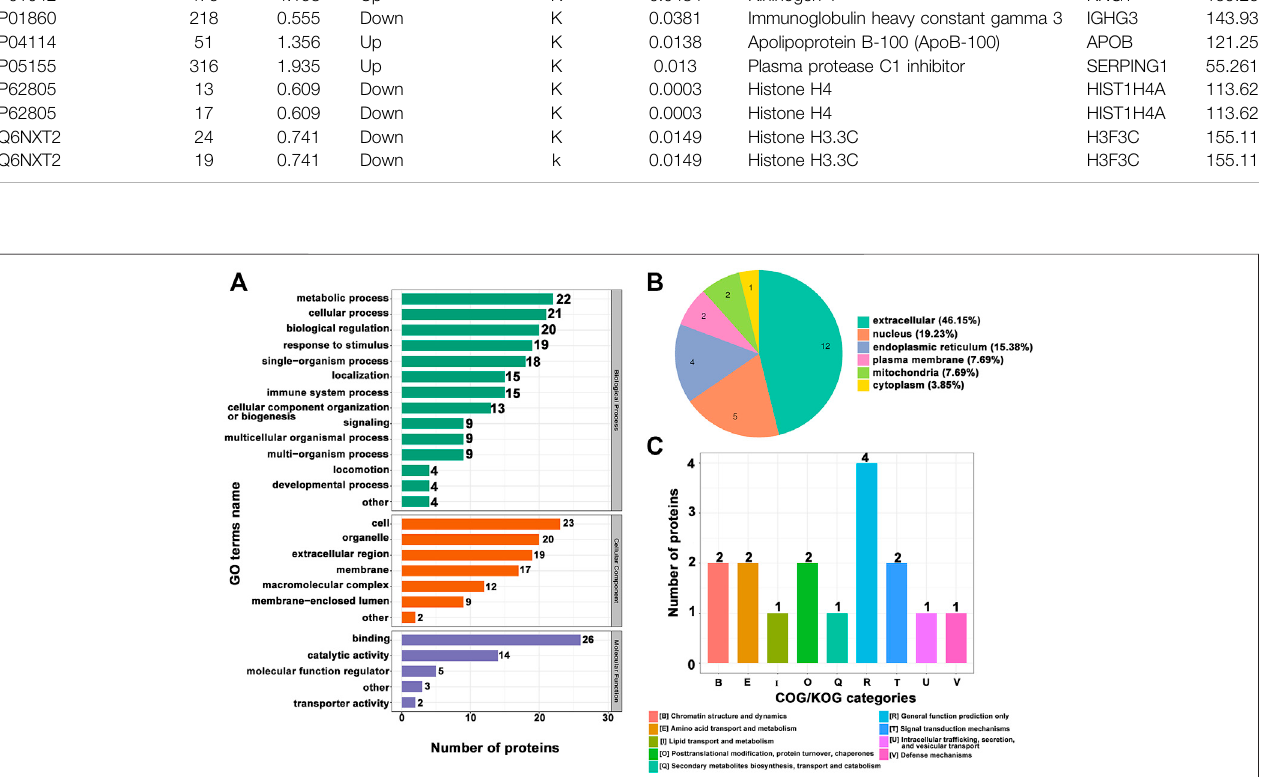
FIGURE 2 | (A) Statistical distribution chart of proteins corresponding to differentially expressed modi fi cation sites under each GO category (second level). (B) Subcellular localization chart of proteins corresponding to differentially expressed modi fi cation sites. (C) COG/KOG functional classi fi cation chart of proteins corresponding to differentially expressed modi fi cation